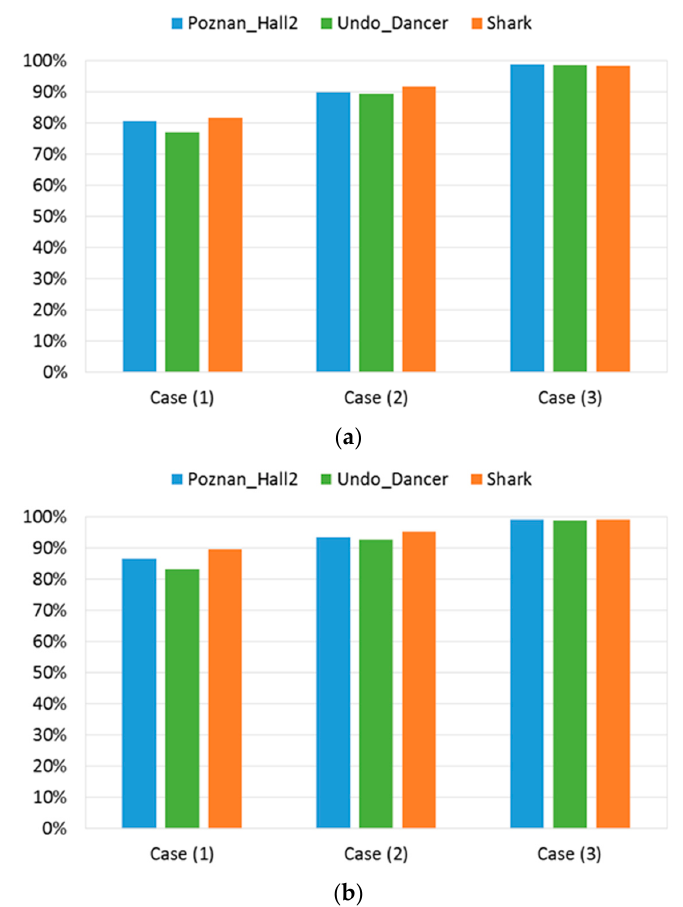
Figure 5. The probability that the optimum mode belongs to several minimum SATD (sum of the absolute transformed difference) cost modes for QPs of ( a ) 39 and ( b ) 42.